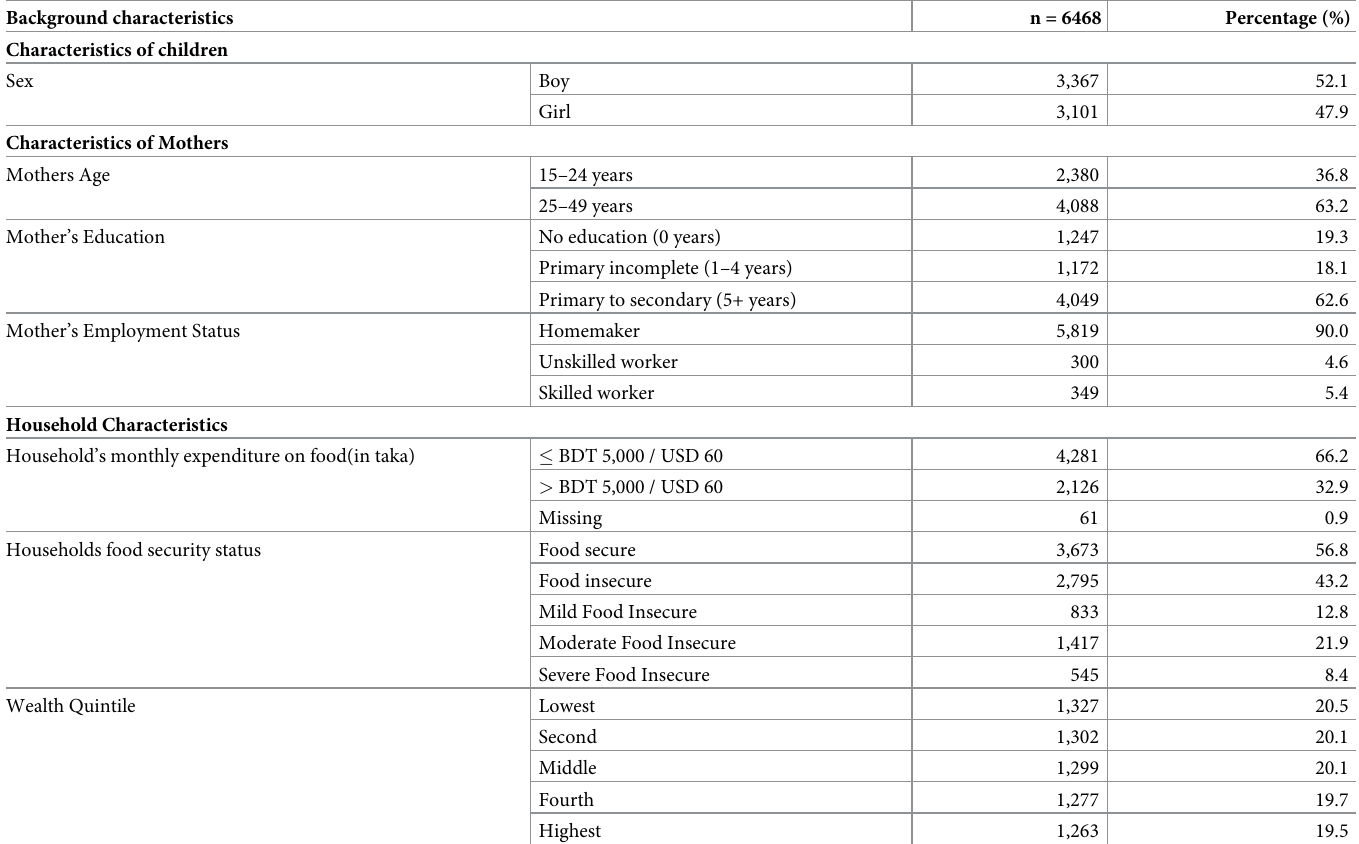
Table 1. Socioeconomic characteristics of households having children aged 06–59 months in rural areas of Bangladesh, 2014. Background